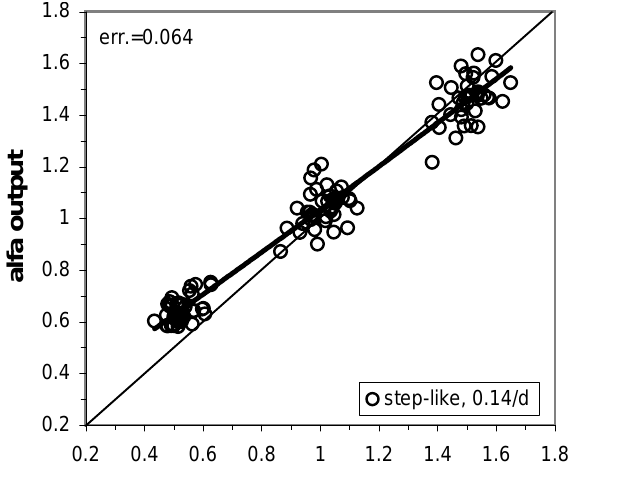
resampled by the selected frequency (0.14 day − 1 and 0.07 day − 1 , left and right picture, respectively) and managed by DFA in order to assess